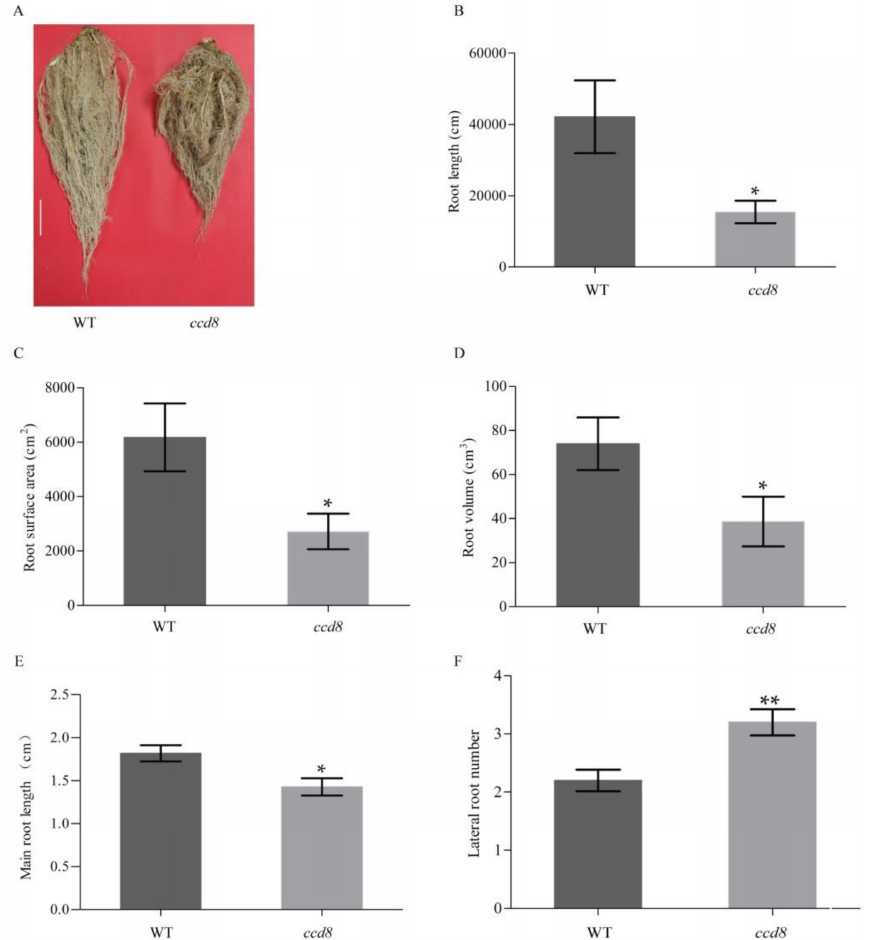
Figure 5. Phenotypic characterization of ntccd8 mutant plants roots. ( A ) Root morphology of wild-type and ntccd8 mutant plants at 50 day after transplantation. The scale bars equal to 6 cm. Total root length ( B ), root surface area c and root volume ( D ) were measured in 50-day-old wild-type and ntccd8 mutant plants. ( E , F ) Average main root length and average lateral root number in wild-type and ntccd8 mutant 10-day-old seedlings. Values are the means ± SD ( n = 20). The asterisks indicate statistically significant differences in comparison to wild-type plants (* p < 0.05 and ** p < 0.01; Student’s t